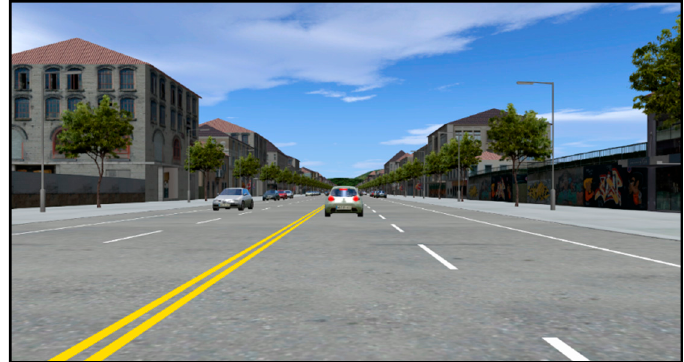
Figure 2. The lead vehicle (LV) sudden braking scenario.